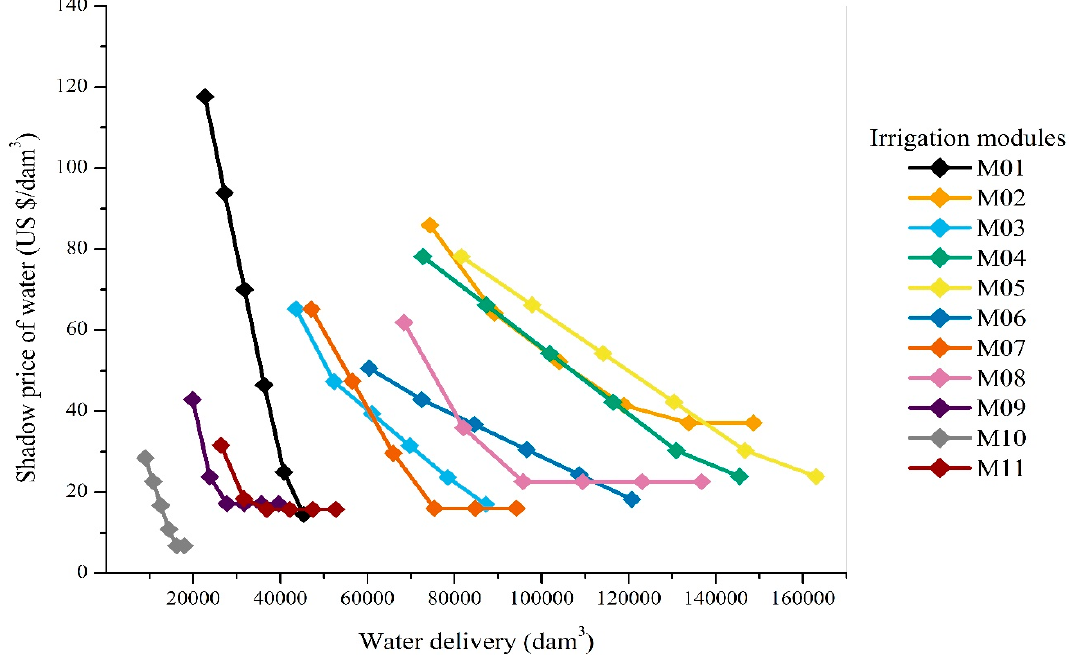
Figure 2. Shadow prices of water in the irrigation modules of the Irrigation District 011.